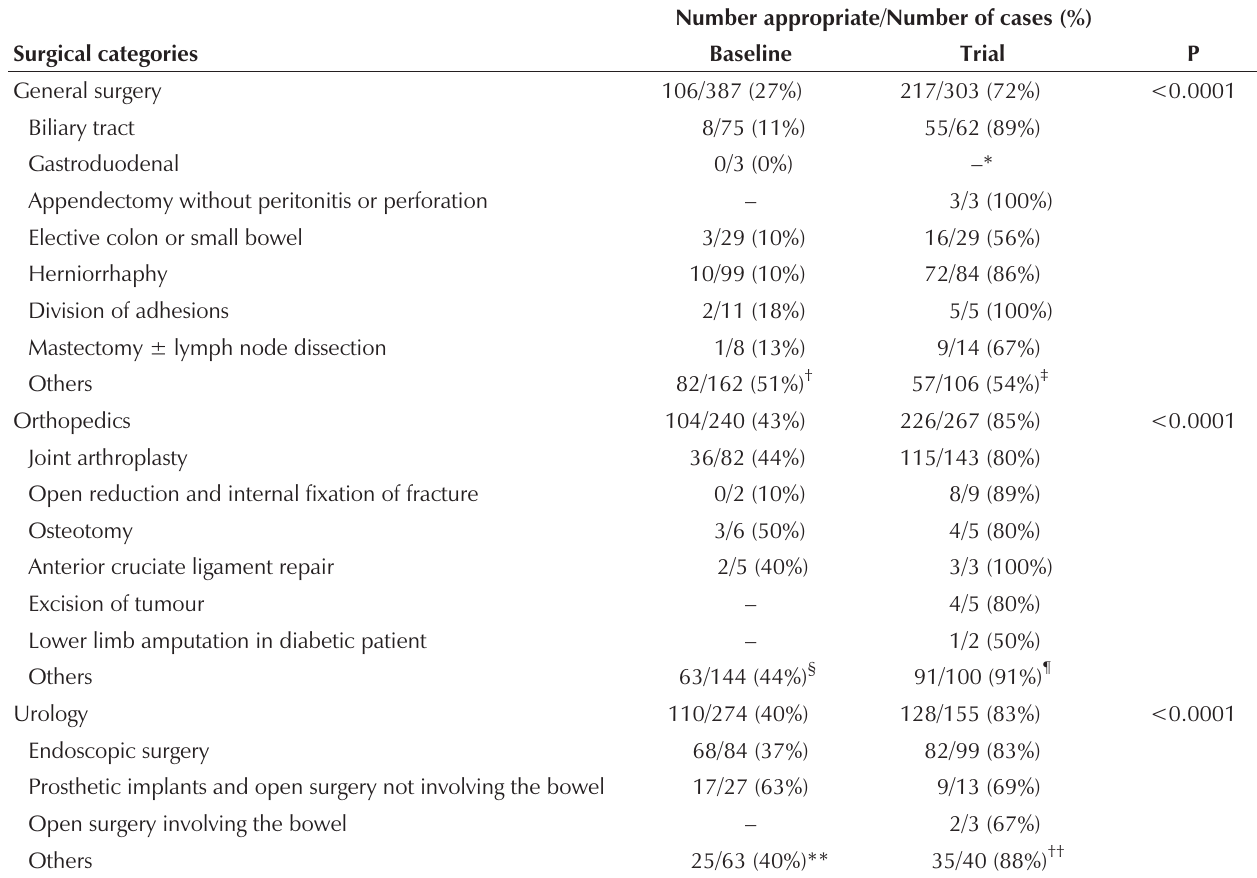
Number appropriate/Number of cases (%)